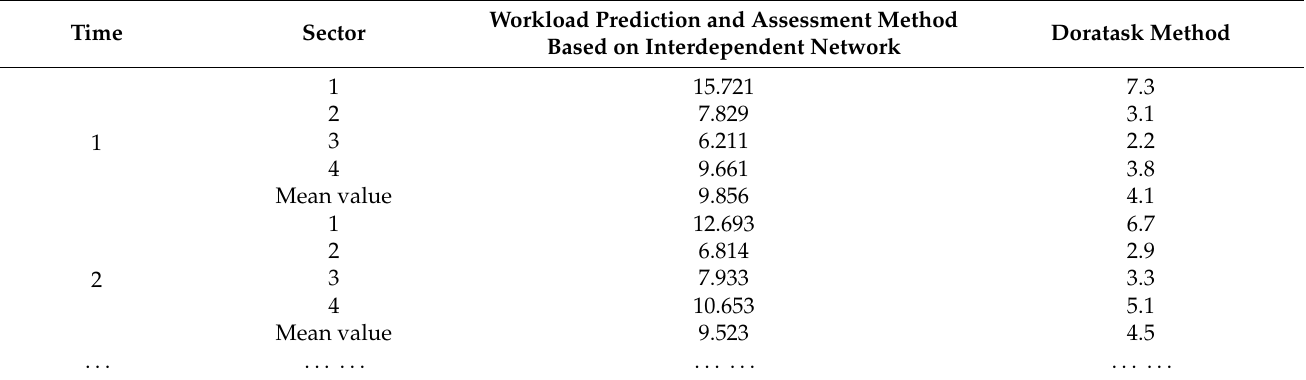
Table 2. Controller workload at different time.